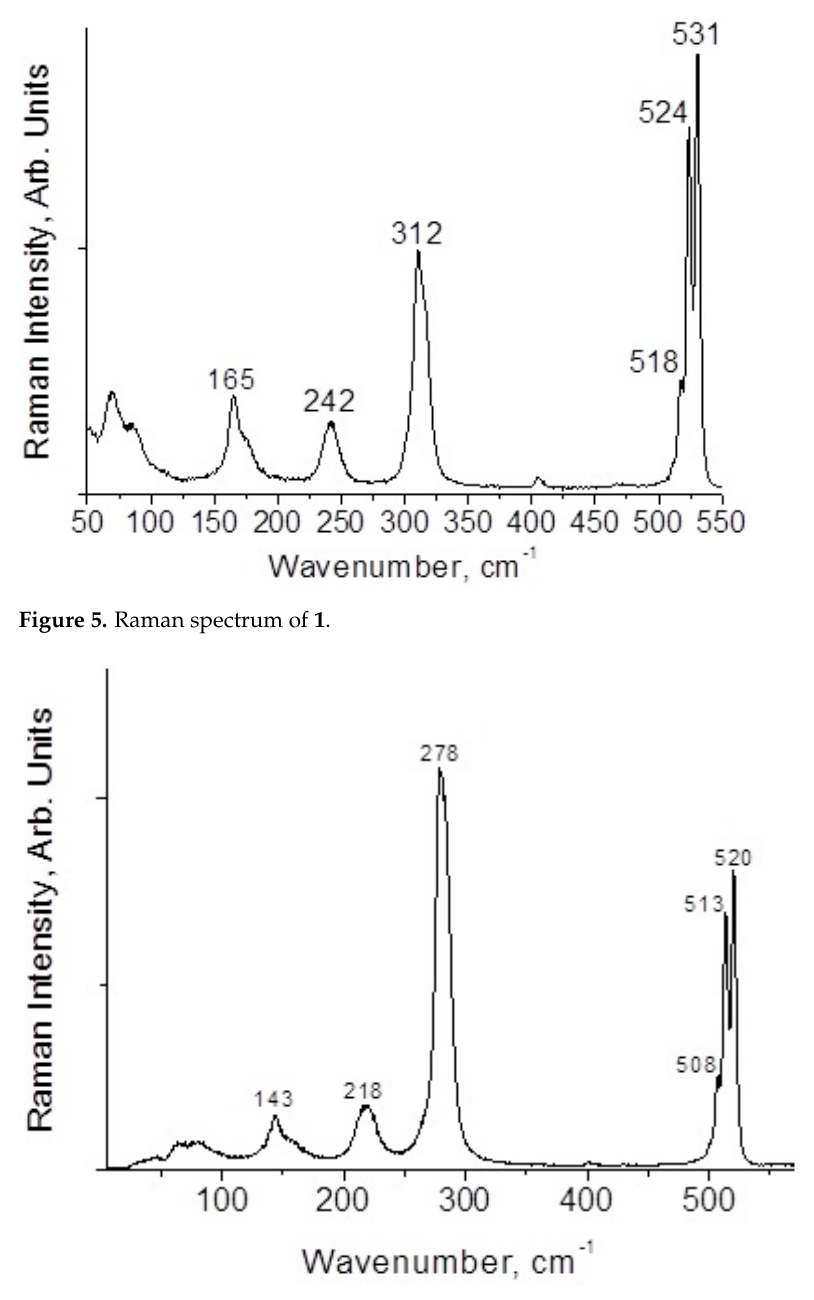
Figure 4. Experimental PXRD pattern of sample 2 after 1 h (blue) and calculated patterns of 2 (black)